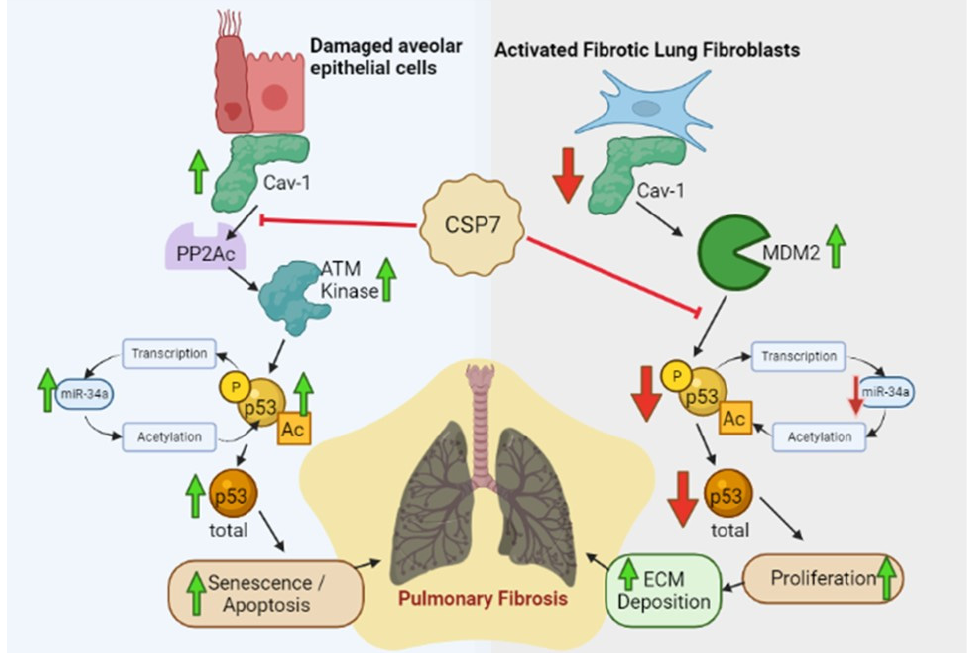
Figure 1. Differential effects of CSP7 on injured AECs and activated fLfs. Competitive inhibition of Cav1 signaling in injured AECs and concurrent complementation of Cav1 signaling in fLfs by CSP7 alleviate disparities in basal p53 levels and resolve existing PF.